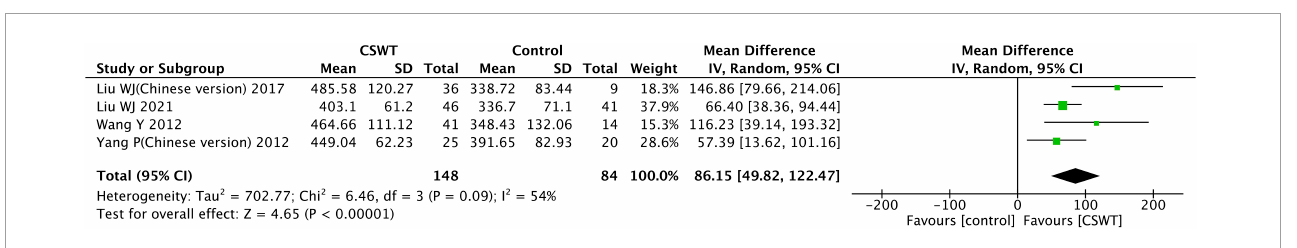
FIGURE8 Forest plot of the CSWT group vs. the control group-6MWT.